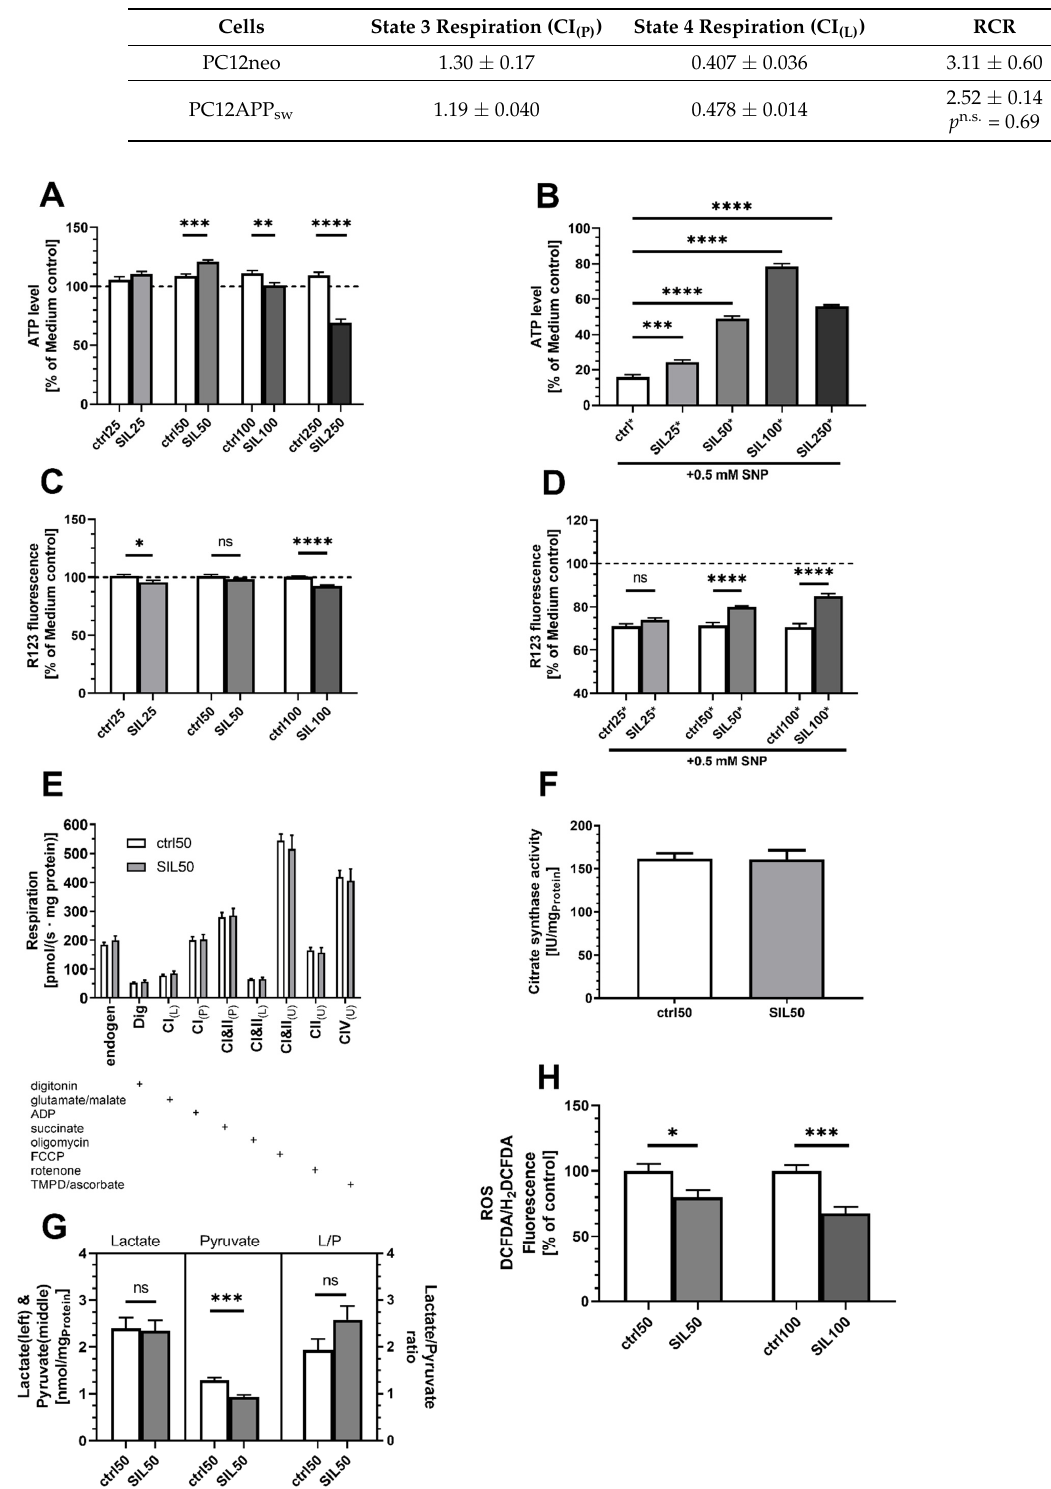
Table 1. Respiration control ratio of PC12neo and PC12APP sw cells. RCR was calculated from CI (L) and CI (P) acquired in the respiration experiment. n = 11. Displayed are the means ± SEM. Statistical significance was tested via Mann–Whitney t -test ( p n.s. > 0.05).